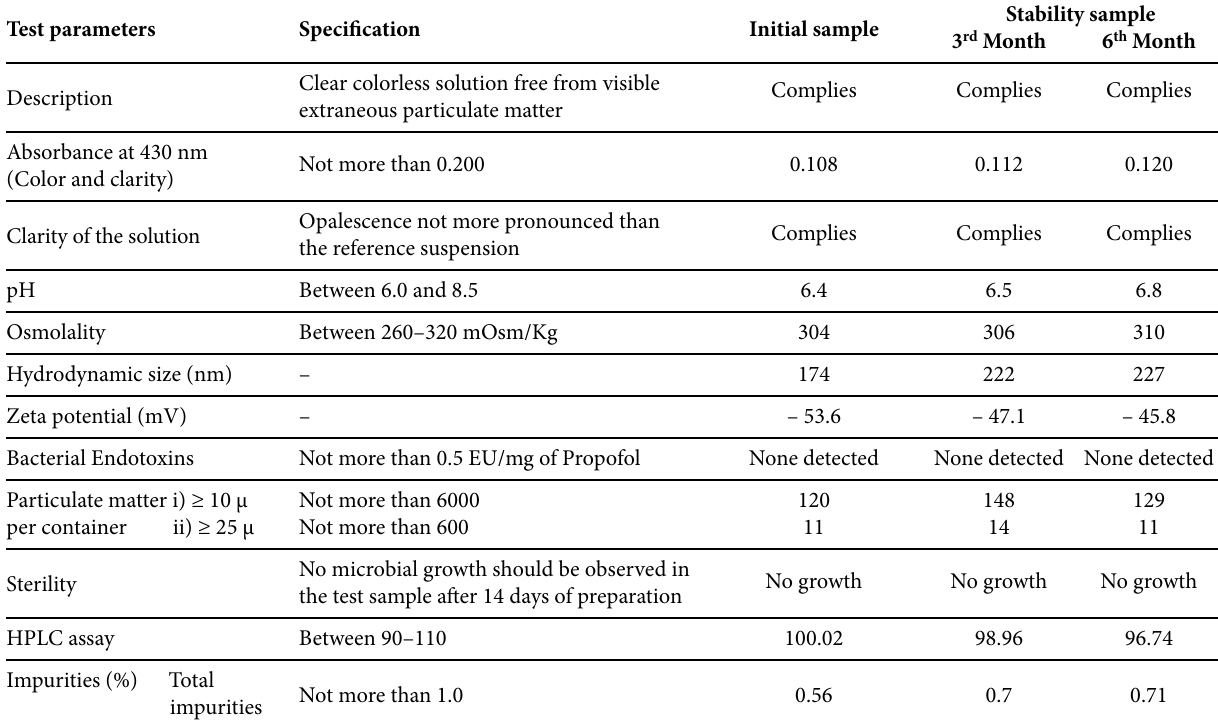
Table 2. Stability analysis of the